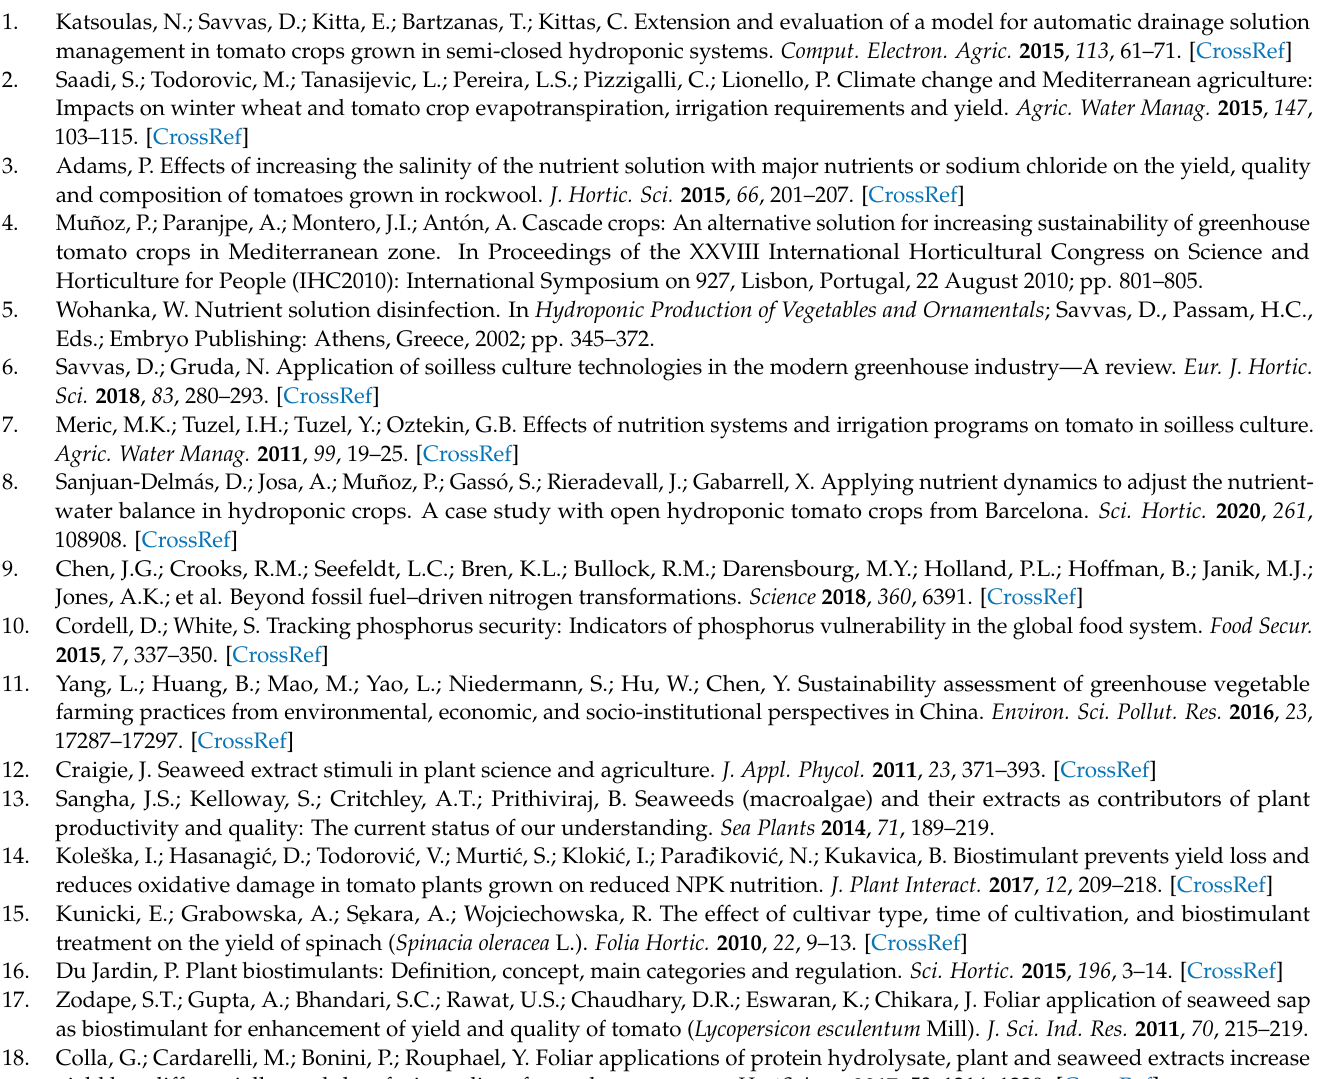
Figure A2. Application of Maxicrop as substrate drench at 5 DAT concomitantly at one irrigation event.